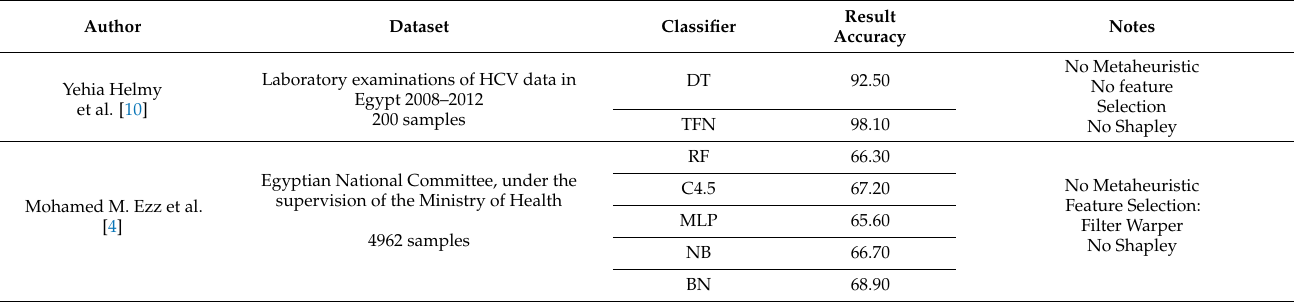
Table 1. Summary of related